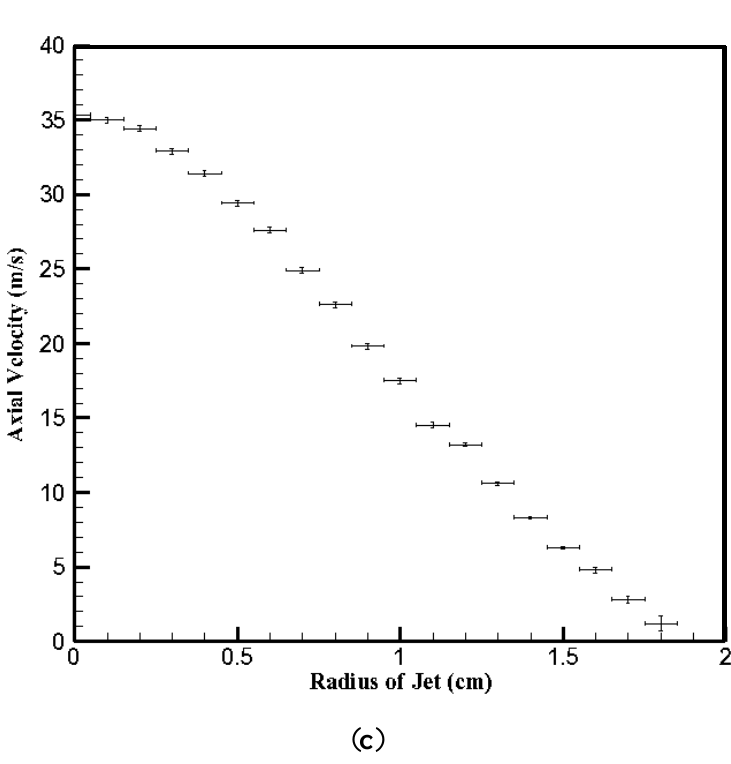
Figure 7. Axial velocity vs. radius for ( a ) Experiment 1 at z = 20 cm; ( b ) Experiment 2 at z = 20 cm; ( c ) Experiment 3 at z = 20